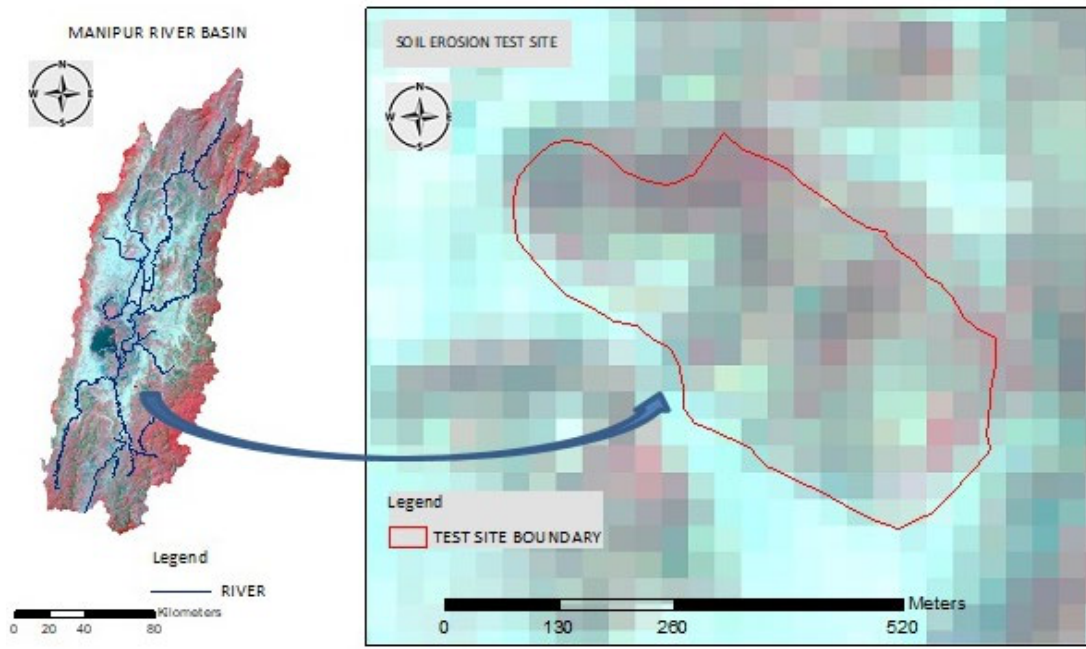
Fig. 9: Soil erosion test site within the basin